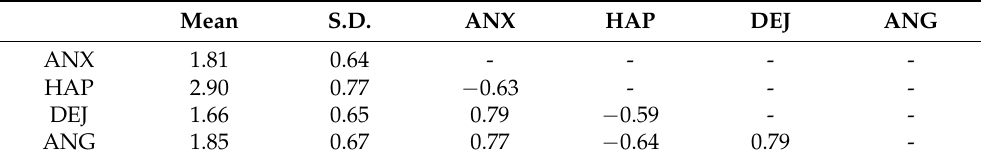
Table 3. Descriptive statistics and correlation values.